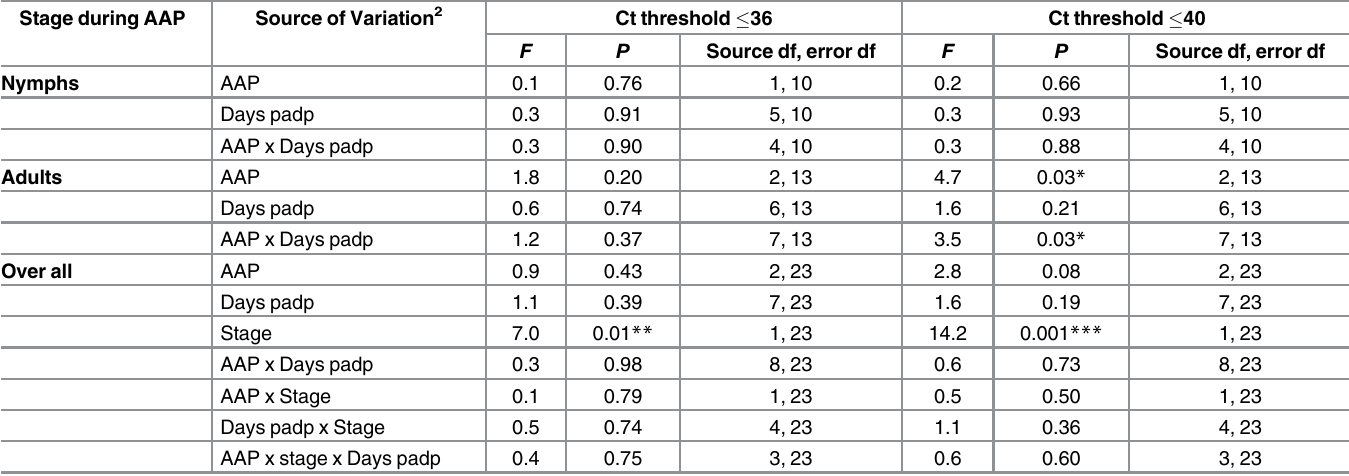
Table 2. ANOVA on the proportion of D . citri testing Las-positive by qPCR (analyses done on arcsine-transformed percentages) 1 . Stage during AAP Source of Variation